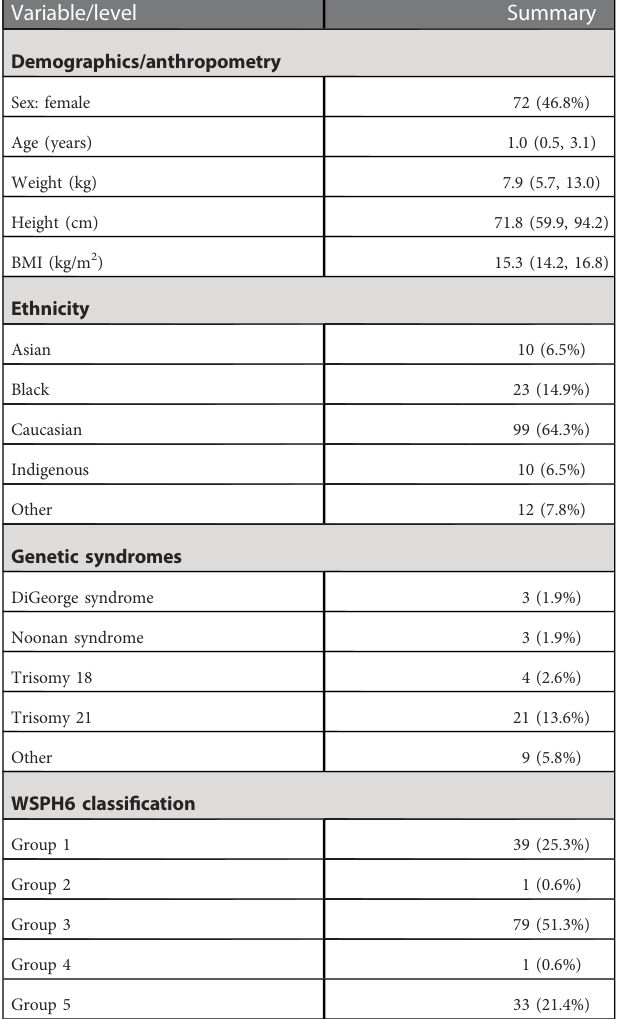
TABLE 1 Patient demographic and clinical characteristics at tadala fi l initiation, summarized as median (Q 1 , Q 3 ) or count (%). Variable/level